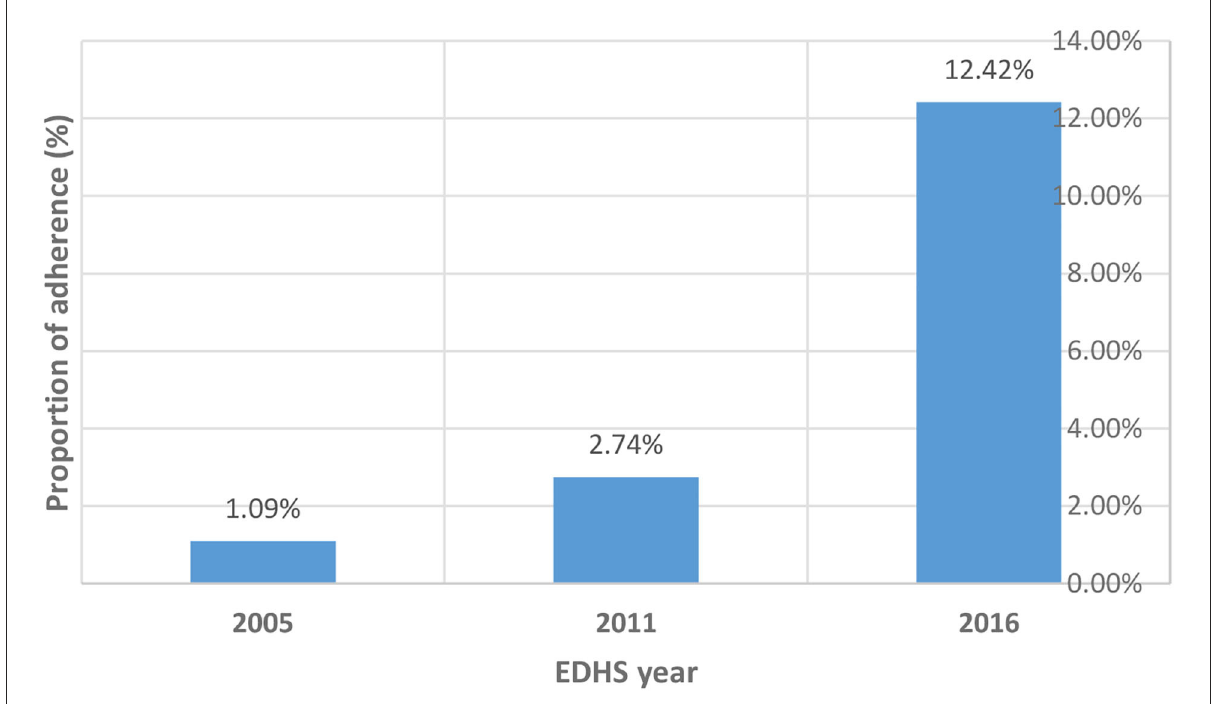
FIGURE1 Proportion of adherence levels across three consecutive